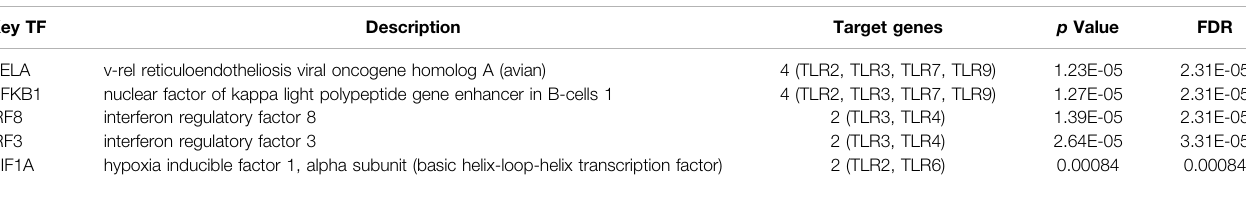
TABLE 2 | The key transcription factors regulating the expressions of TLRs in KIRC